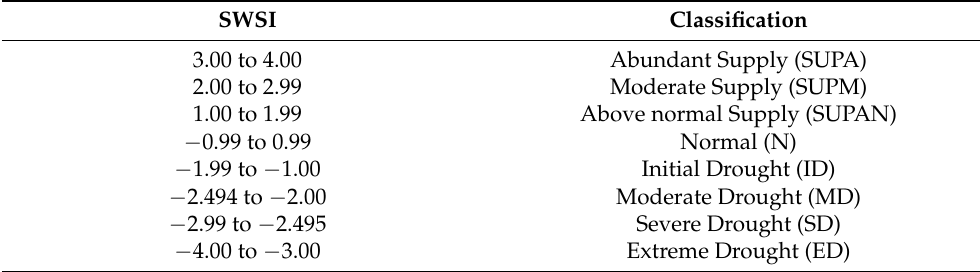
Table 2. SWSI classification of water availability in